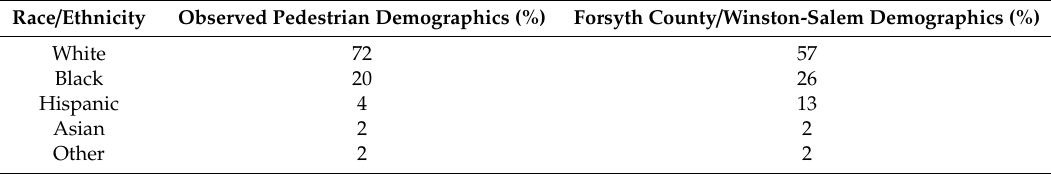
Table 4. Observed pedestrian demographics compared to census data of